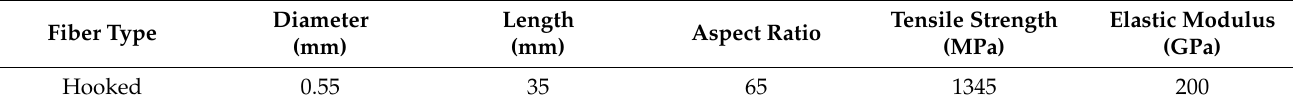
Figure 1. Dimensions of SF.